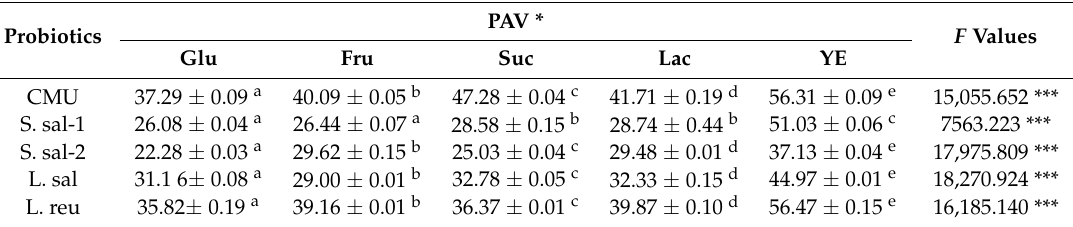
Table 1. The ability of oral probiotic strains to produce acid.